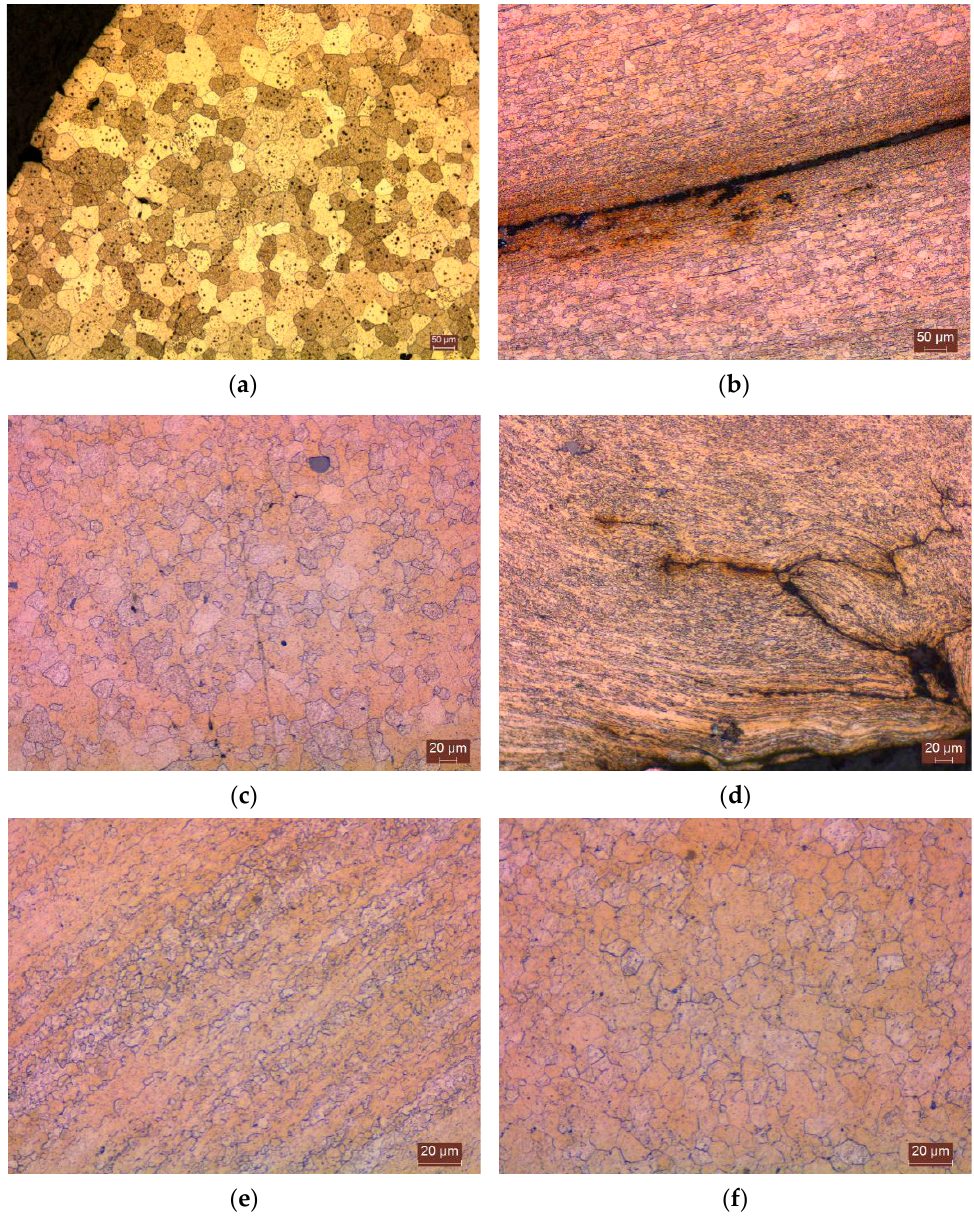
Figure 14. Microstructural morphology of Mo. ( a ) Initial structure; ( b , c ) Slug structure; ( d – f ) Jet structure.